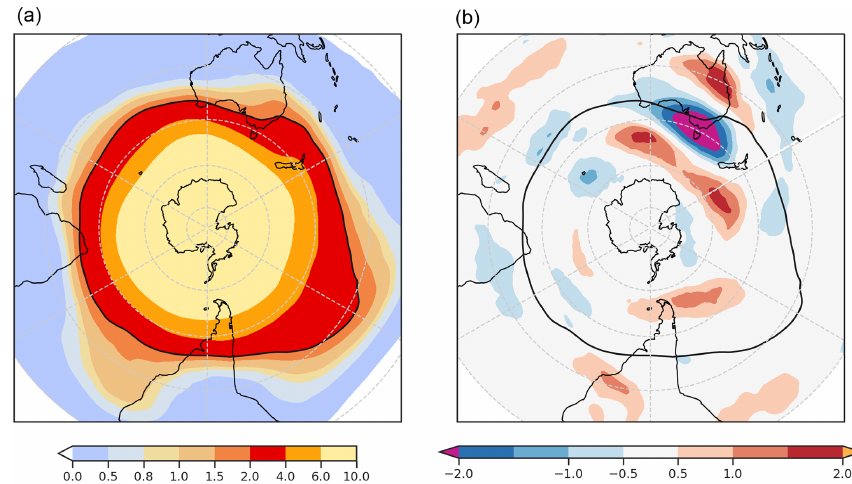
Figure D1. (a) PV composite mean at 350K isentrope for SEA heatwave days and (b) the respective anomalies with DJF mean